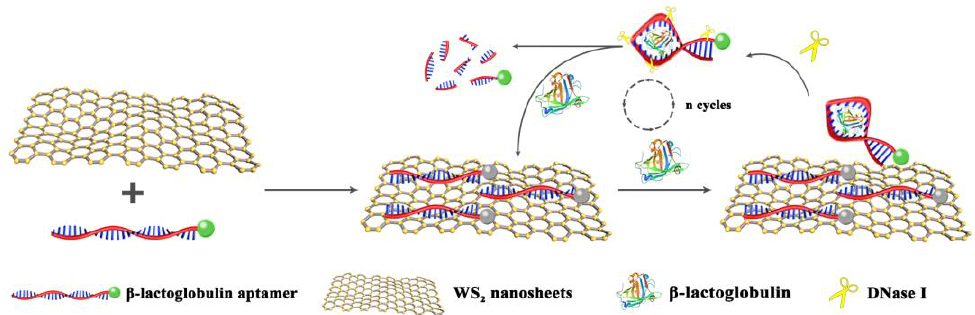
Figure 1. Working principle of the fluorescent aptamer biosensor for β-Lg